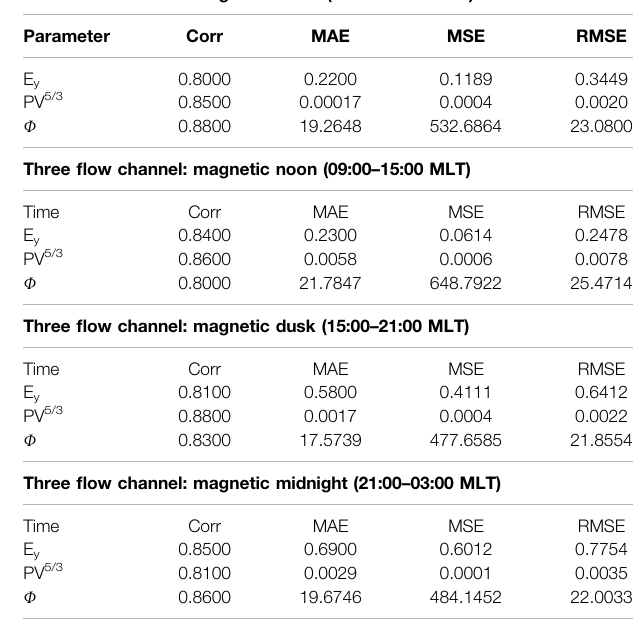
TABLE 1 | Error Analysis for Single Bubble injection.